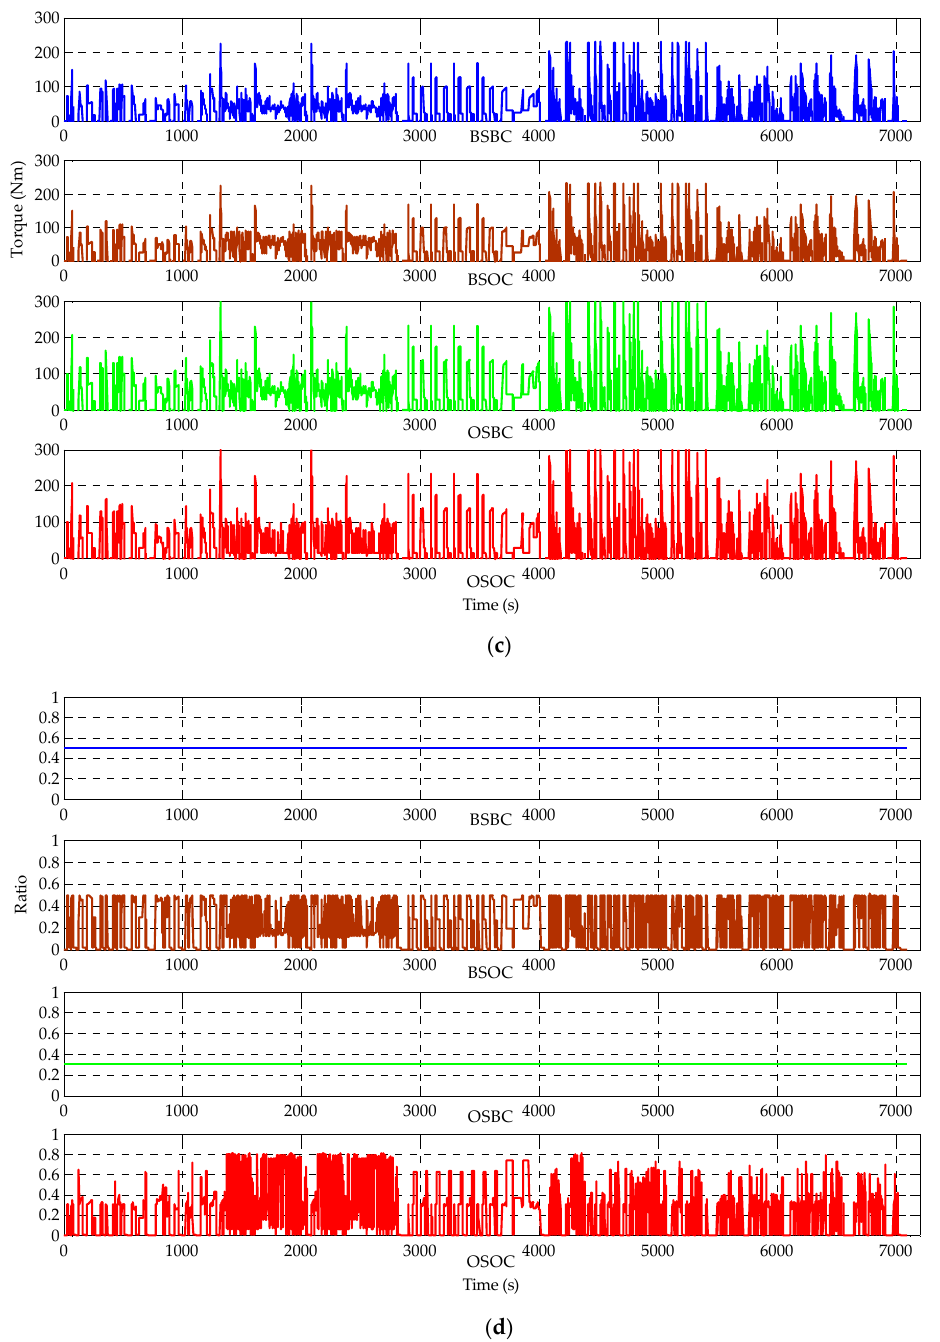
Figure 10. Demand speed and torque distribution of the front and rear wheel motors under the hybrid driving cycle. ( a ) Driving cycle; ( b ) the torque distribution of the front-axle motors; ( c ) the torque distribution of the rear-axle motors; ( d ) the distribution ratio of the front-axle motors.